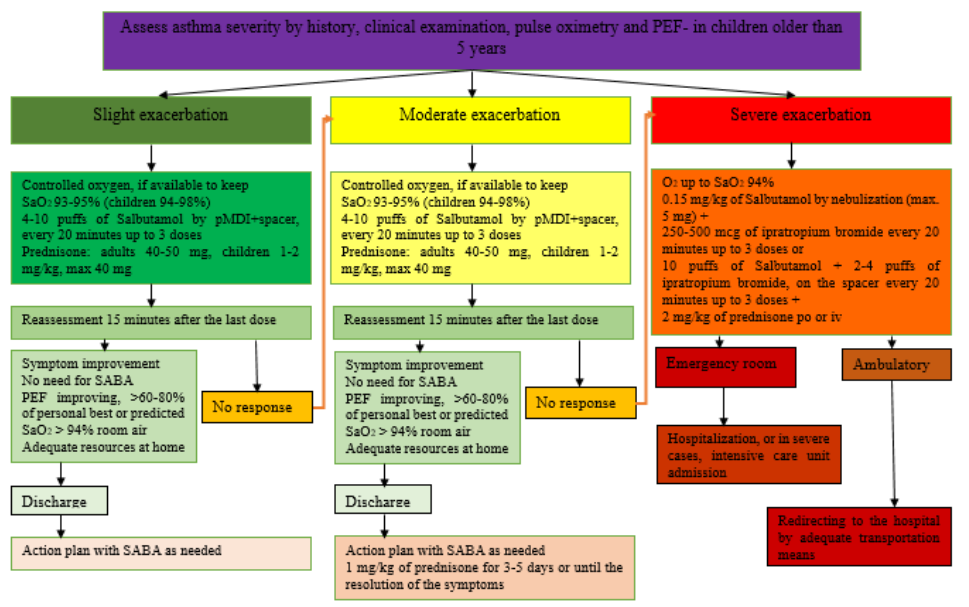
Figure 4. Therapeutic management of acute exacerbations adapted from the Spanish asthma manage- ment guide GEMA 5.0 [3] and GINA 2022 [6].